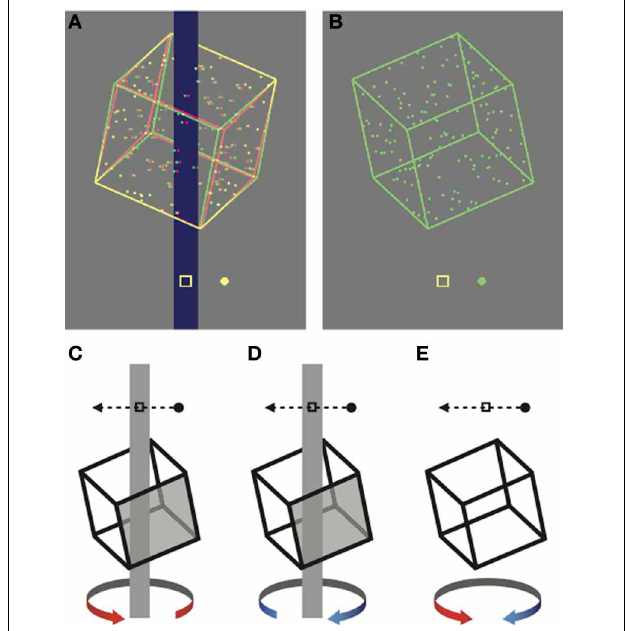
FIGURE 1 | Cropped screen shots of the stimuli, rendered here for red-green anaglyph presentation. (A) Unambiguous stimulus disambiguated by occlusion and disparity cues. (B) Ambiguous stimulus presented monocularly. (C–E) Schematic representations of the task. Participants reported whether the front face of the cube (shaded in the unambiguous examples) moved in (D) the same direction as the probe dot or (C) the opposite direction to the probe dot. (E) On ambiguous trials the task was the same, but there was no correct answer.